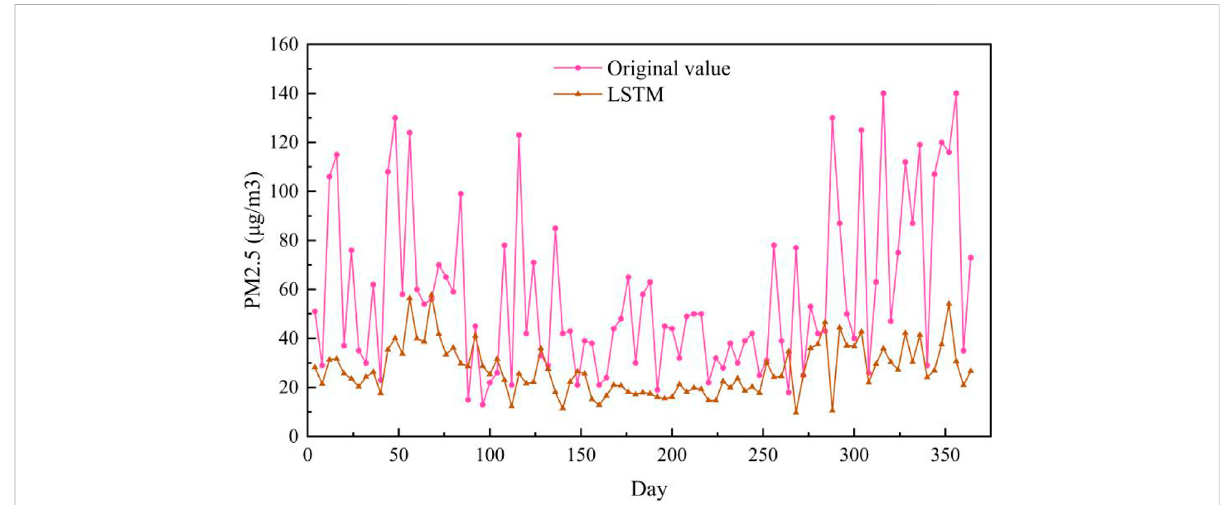
FIGURE 7 Experimental results of LSTM method in Baoding test set.